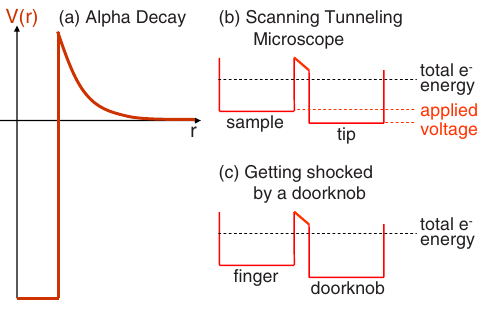
FIG. 11. (cid:1) Color (cid:2) Potential-energy graphs for (cid:1) a (cid:2) an alpha par- ticle undergoing alpha decay, (cid:1) b (cid:2) an electron in a scanning tunneling microscope, and (cid:1) c (cid:2) an electron in your finger when you get shocked by a doorknob. Determining how to draw each of these graphs requires many